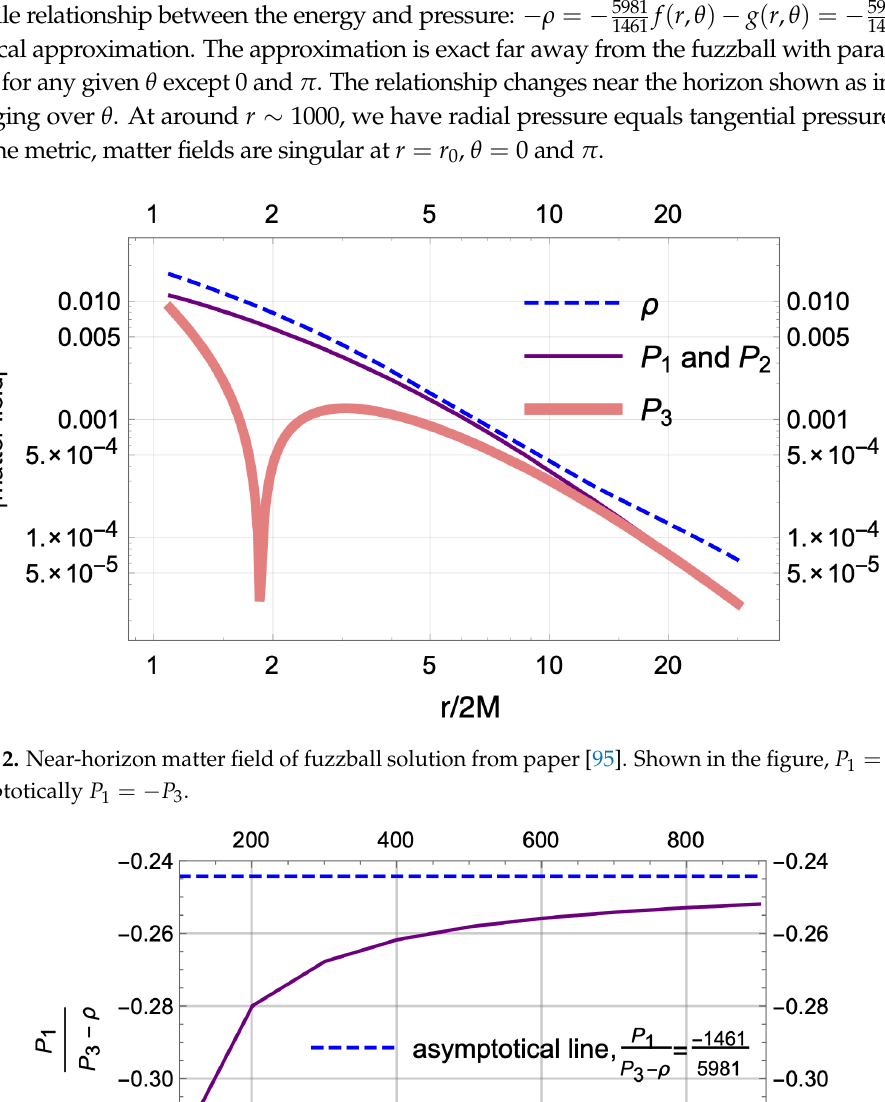
Figure 3. Near-horizon relationship between density and pressure of the fuzzball solution from paper [95]. The dashed line is the asymptotic behavior, and the solid line is the real behavior of P 1